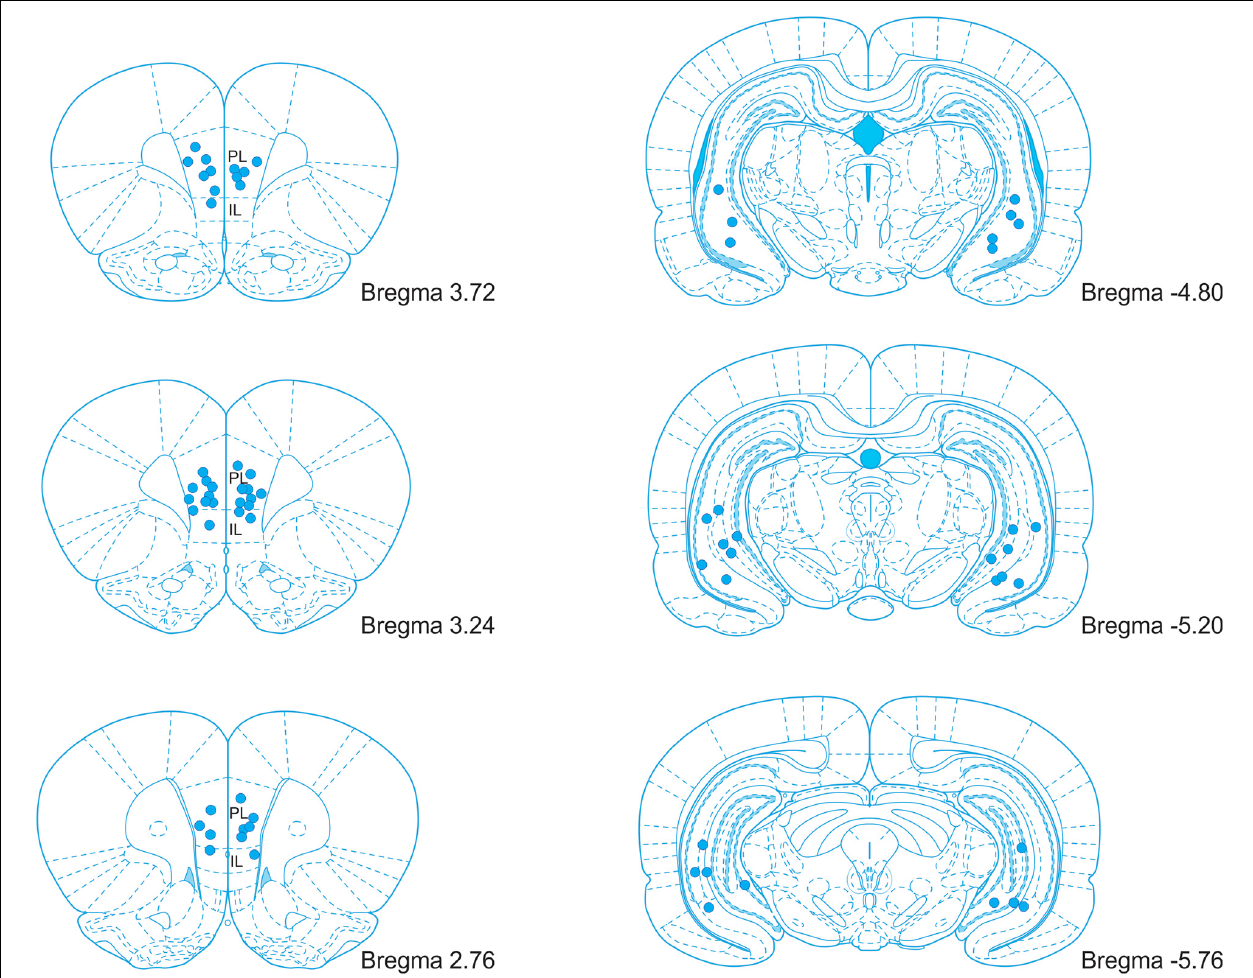
FIGURE 2 | An illustration of the cannula placement locations in the mPFC and vHPC. PL, prelimbic cortex; IL, infralimbic cortex. Adopted from Paxinos and Watson